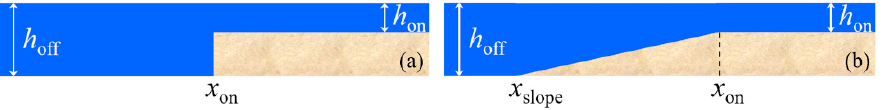
Figure 2. Two types of seabed topography, where h off = 5000 m: ( a ) Stepped seabed topography. ( b ) Partially sloping topography. The calculation conditions are listed in Table